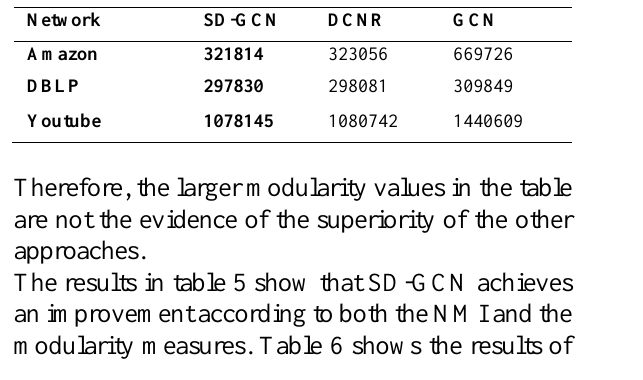
Table 8. Number of boundary